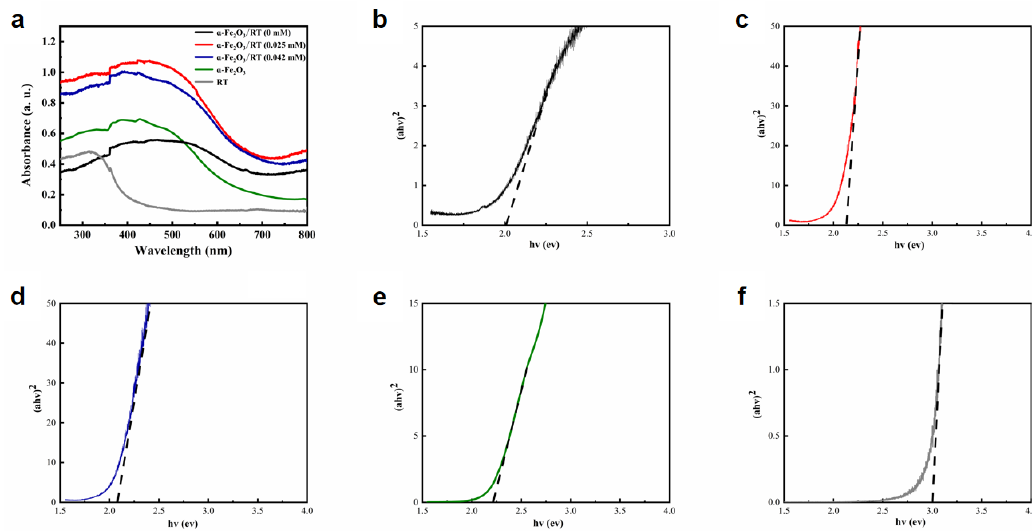
Figure 9. ( a ) UV-vis diffuse reflectance spectra and plots of ( α hv) 2 vs. photon energy hv for samples of ( b ) α -Fe 2 O 3 /RT (0 mM), ( c ) α -Fe 2 O 3 /RT (0.025 mM), ( d ) α -Fe 2 O 3 /RT (0.042 mM), ( e ) α -Fe 2 O 3 , and ( f ) RT.